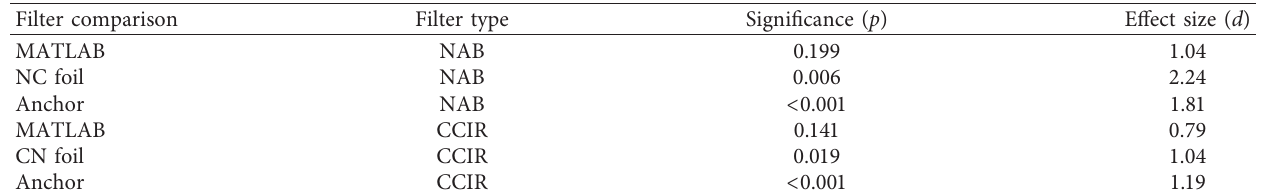
Table 5: Results of paired sample t -tests between the Hidden reference and the remaining filters. Tests have been collapsed across the 3 NAB stimuli or the 3 CCIR stimuli. Bonferroni correction has been applied to p values. Effect size refers to Cohen’s d . Filter